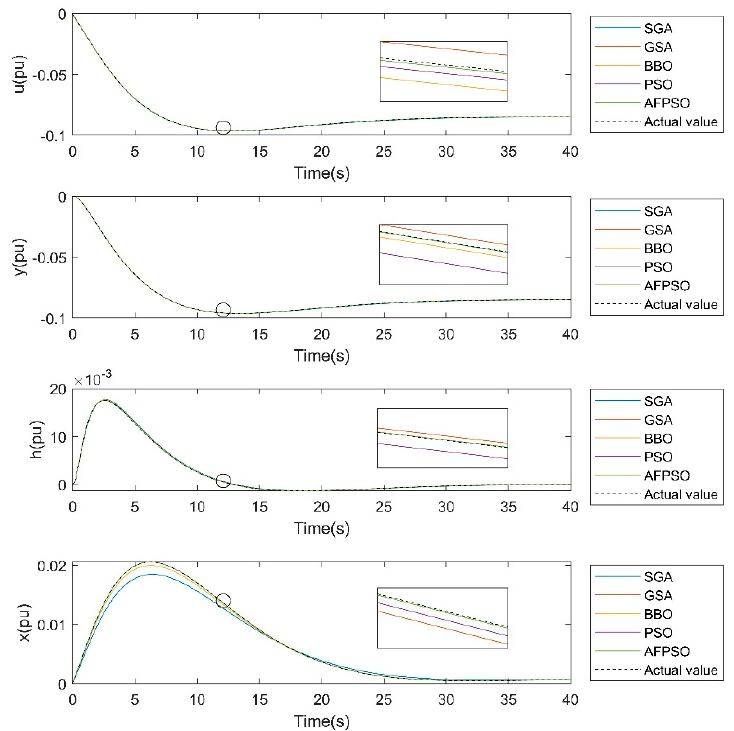
ff erent algorithms (Load